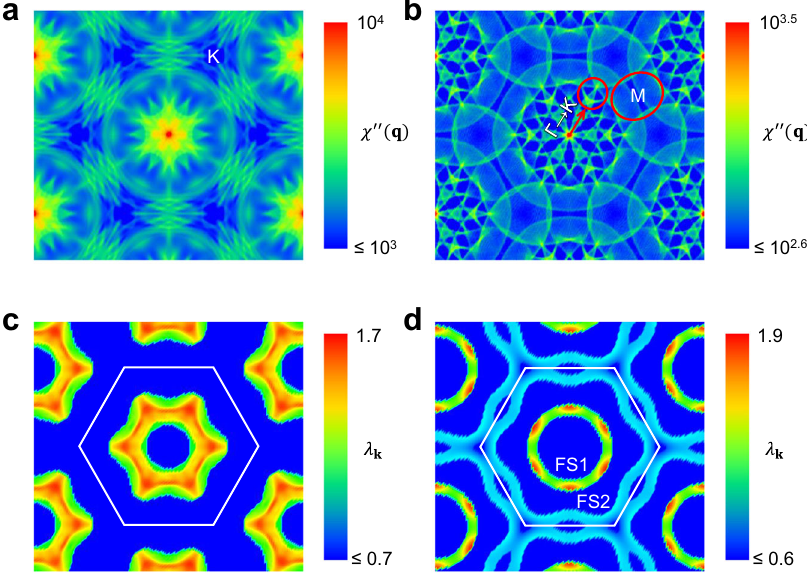
Fig. 4 Unveiling the EPC mechanisms. FS nesting function χ 00 q ð Þ of a monolayer ZrCl and b monolayer MoCl. Notice the peaks at Γ point are irrelevant to the nesting. Electronic EPC strength λ k of c monolayer ZrCl and d monolayer MoCl near Fermi level (within E F ± 0.2 eV) at 6